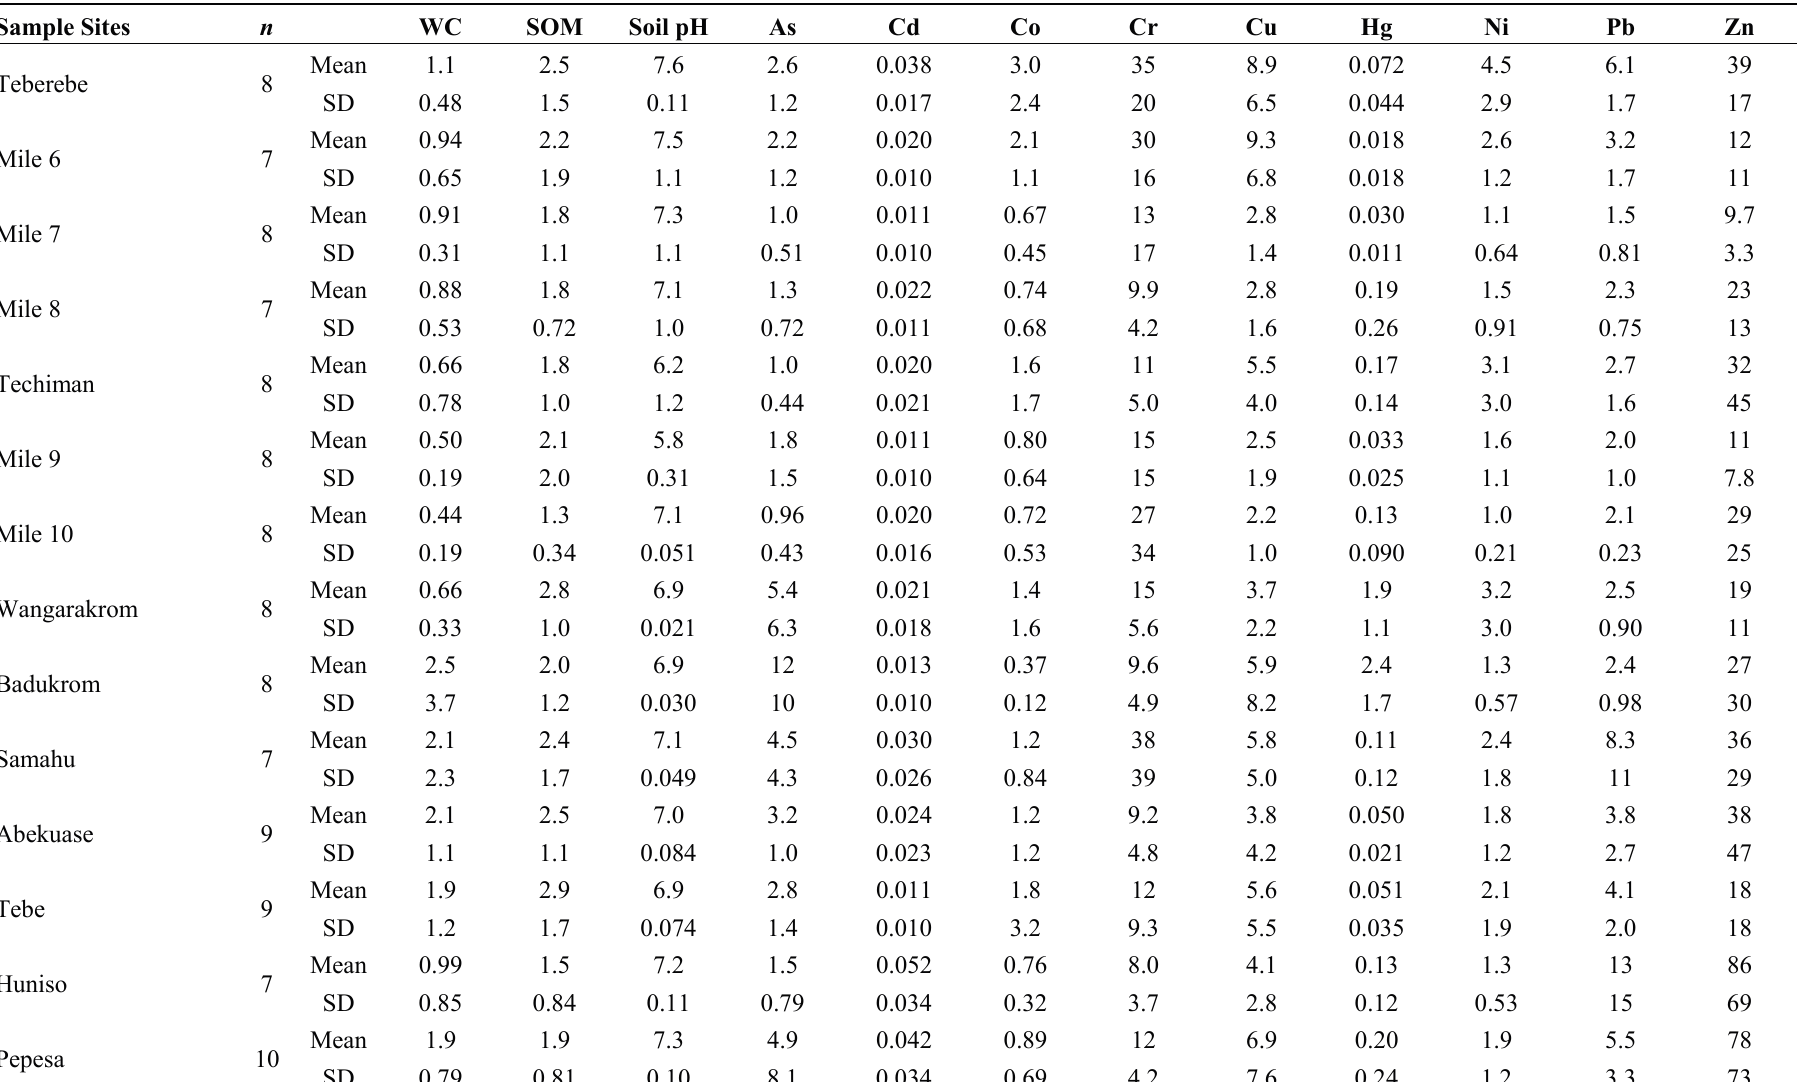
Table 1. WC%, SOM%, soil pH and mean (±SD) concentrations (mg/kg dw)) of heavy metals and a metalloid in soils in Tarkwa. Sample Sites